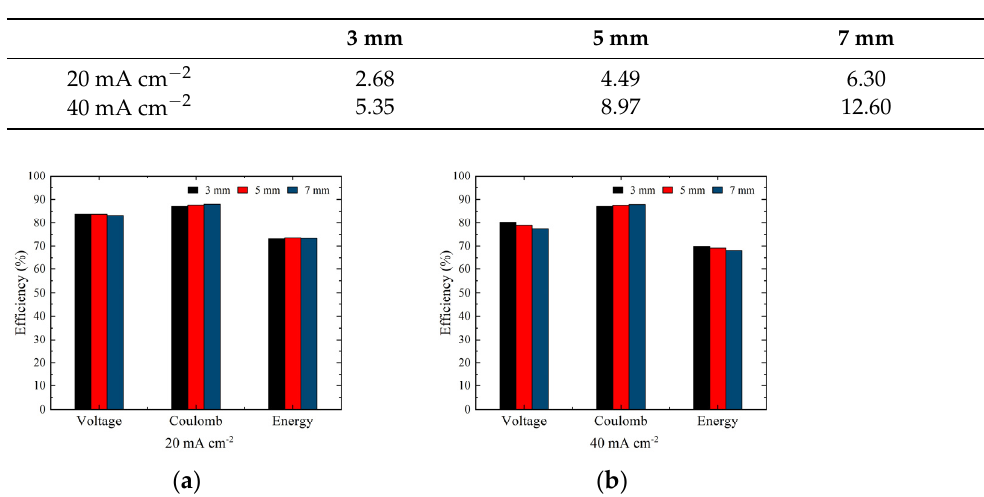
Figure 10. Voltage, coulomb, and energy efficiency of battery with different electrode thicknesses at current densities of ( a ) 20 mA cm − 2 and ( b ) 40mA cm − 2